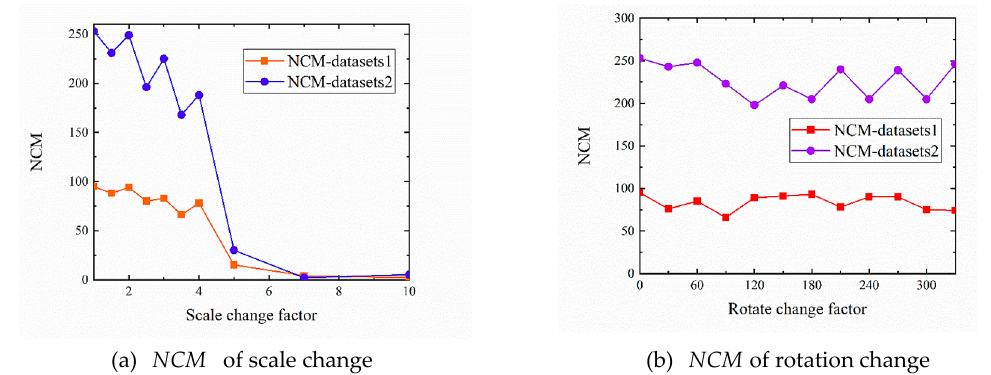
Figure 8. SRIFT matching performance with scale and rotation distortion.